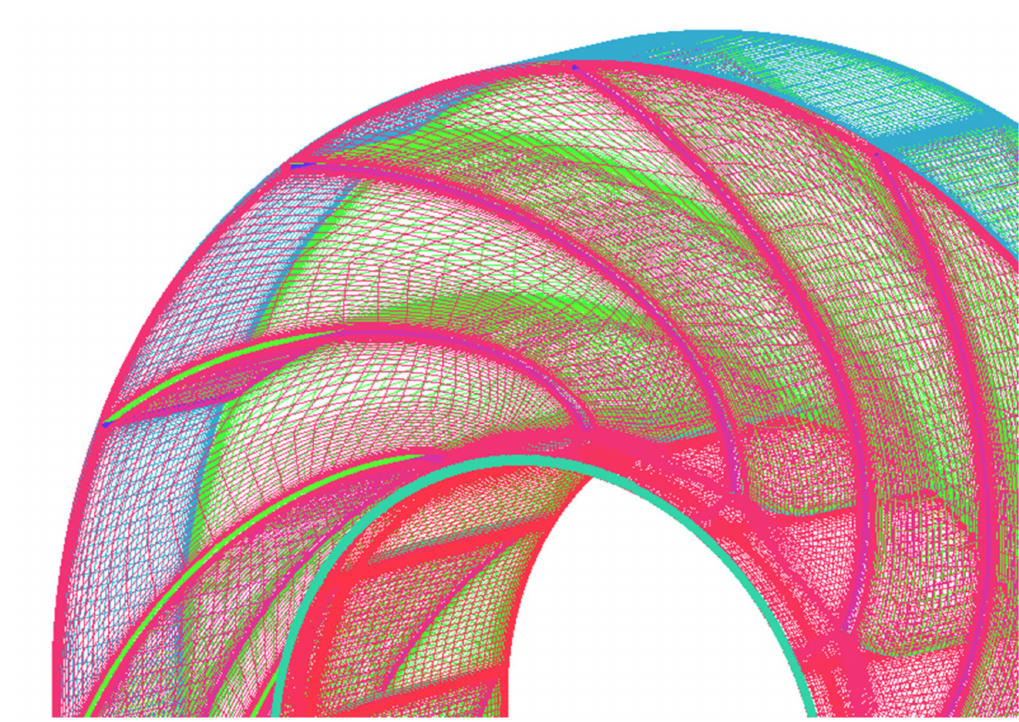
Figure 4. Exemplary mesh on the impeller domain (maximal position of